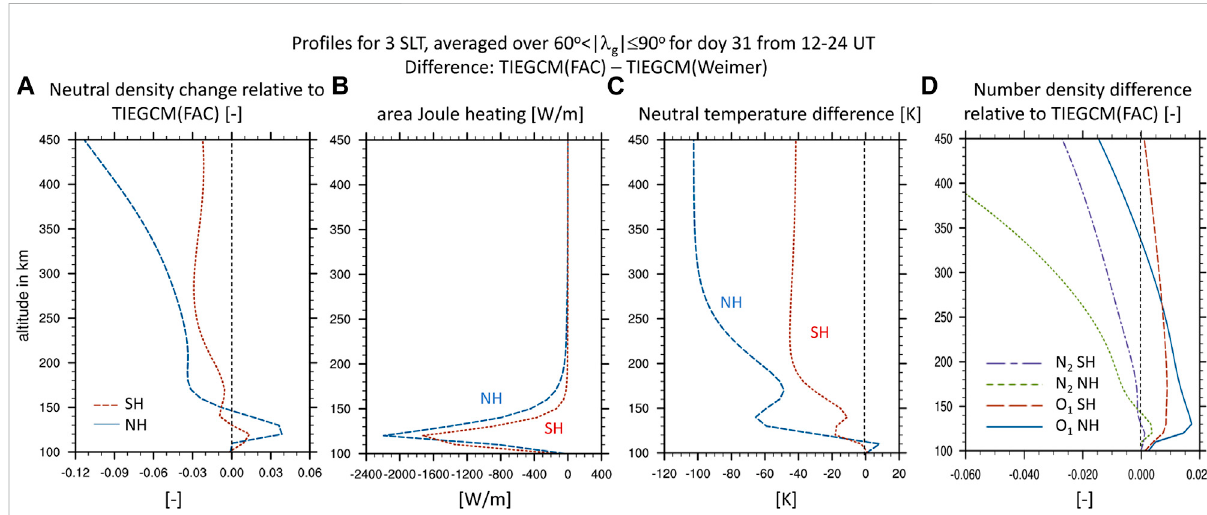
FIGURE 11 Pro fi lesofdifferencesbetweenTIEGCM(FAC)andTIEGCM(Weimer)fornorthernhemisphere(darkbluedashedlines)andsouthernhemisphere (dark orange dotted lines)at 3 h SLT averaged between 60 0 < | λ g | ≤ 90 0 and doy 31.5 to 32. (A) . relative neutral density change with respect to TIEGCM(FAC), (B) .integratedJouleheatingdifference[W/m], (C) .neutraltemperaturedifference[K],and (D) .numberdensitydifferencewithrespect to TIEGCM(FAC) for N 2 (green short dashed for north, purple long-short dashed for south) and O 1 (blue solid for north and orange long dashed for south).